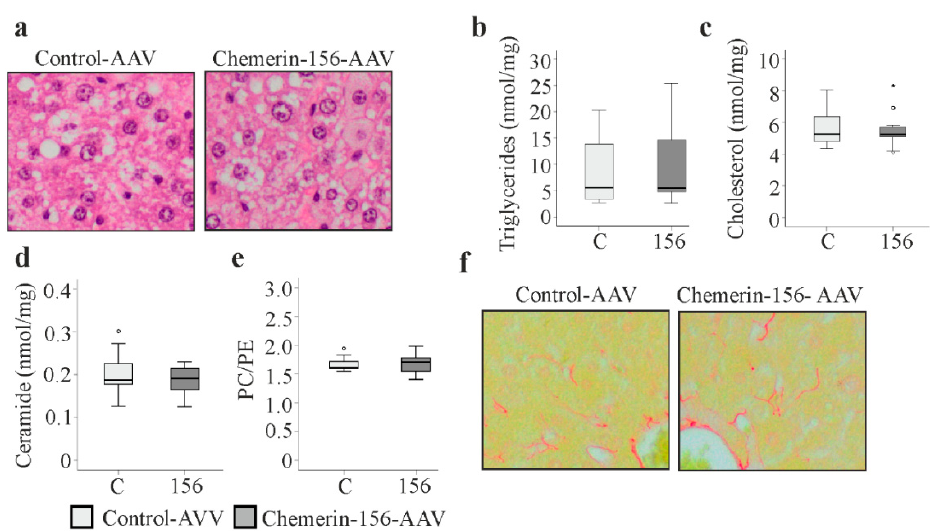
Figure 3. Analysis of hepatic injury in non-tumorous tissue of control-AAV and chemerin-156-AAV infected mice. ( a ) Hematoxylin and eosin stained liver. ( b ) Hepatic triglycerides. ( c ) Hepatic cholesterol levels. ( d ) Hepatic ceramide levels. ( e ) Hepatic phosphatidylcholine / phosphatidylethanolamine (PC / PE) ratio. ( f ) Sirius Red stained liver. Small circles in c, d and e indicate outliers greater than 1.5 times the interquartile range. The star in c indicates an outlier greater than 3.0 times the interquartile